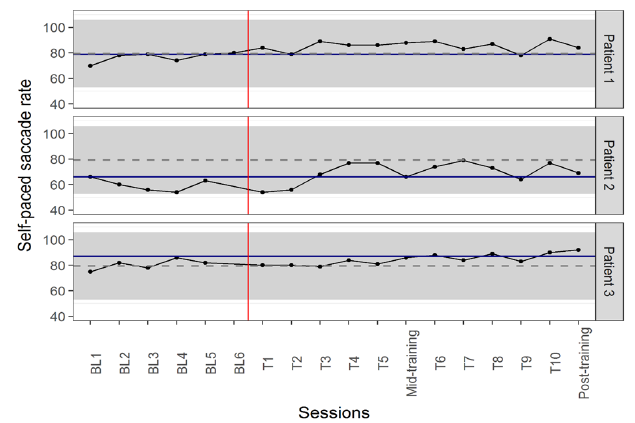
Figure 2: Self-paced saccade rate changes during baseline and training sessions (The number of self-paced saccades during 30 seconds was counted). Solid blue line represents the highest baseline value for each patient. Grey dashed lines and grey backgrounds show the mean ± standard deviation in healthy non- gamers participants. The red vertical line separates the baseline and training periods. BL = baseline and T= training